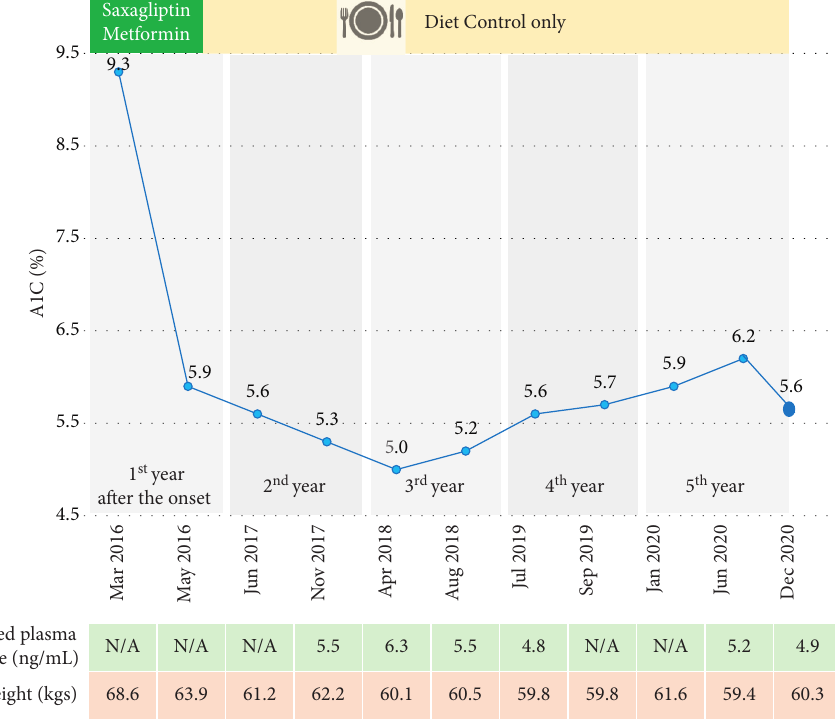
Figure 2: Clinical course and sequential laboratory data in this